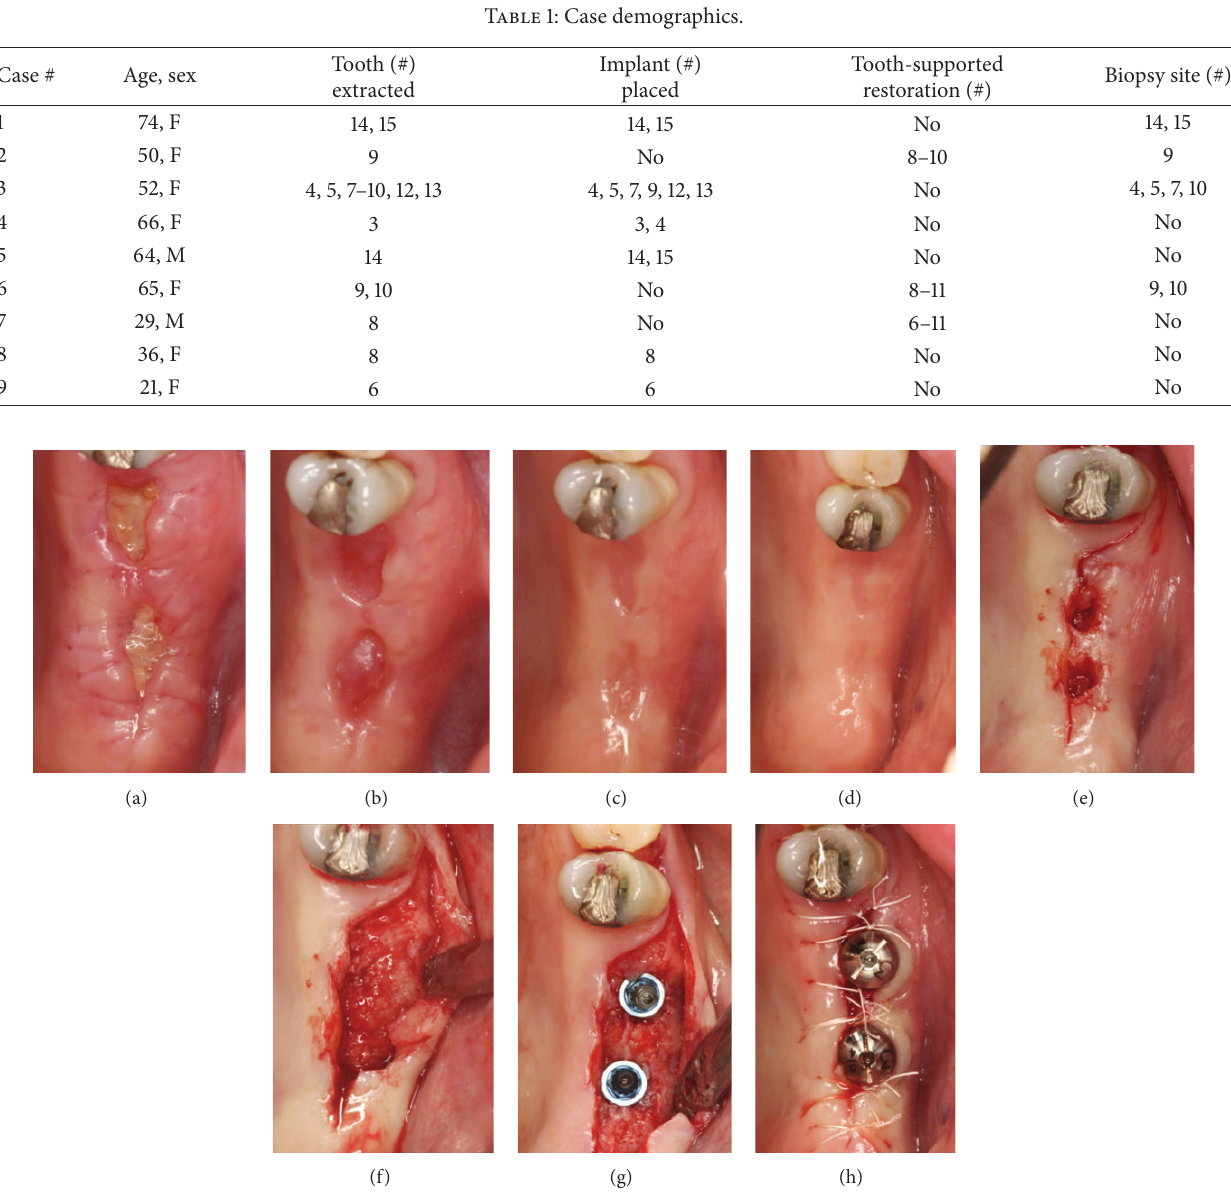
Figure 4: Clinical views of Case 1. Postoperative appearance at (a) 2 weeks, (b) 4 weeks, (c) 3 months, and (d) 6 months; after (e) soft tissue biopsies, (f) flap elevation, and (g, h) implant